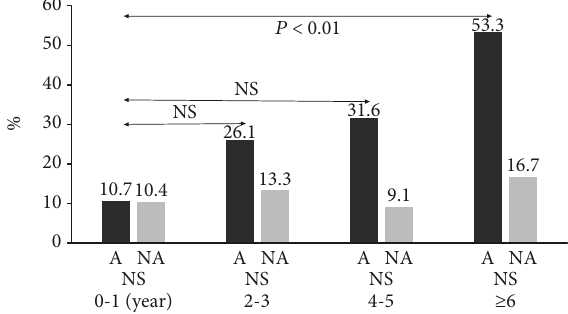
Figure 2: RAST-positive rates by age. A, asthma group; NA, nonasthma group. Positive RAST rates were signi fi cantly higher in the older age groups than in the 0 – 1-year-old age group (NS, p < 0 01 ).